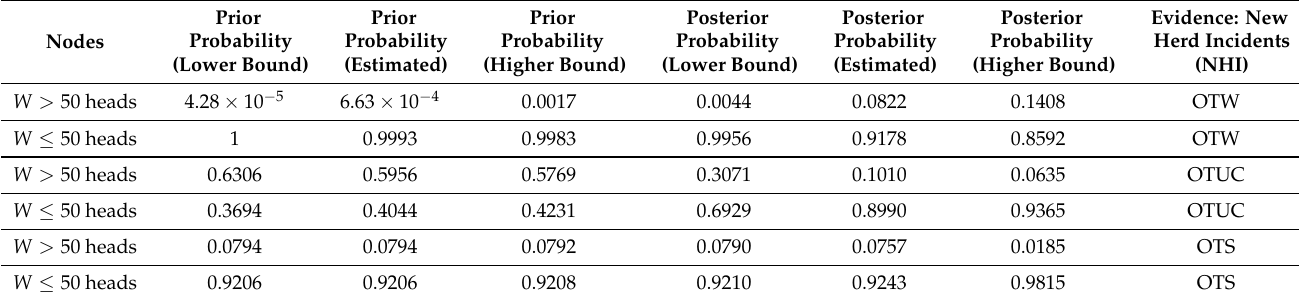
Table 8. Prior and posterior probabilities for node W in high-risk areas of England cattle